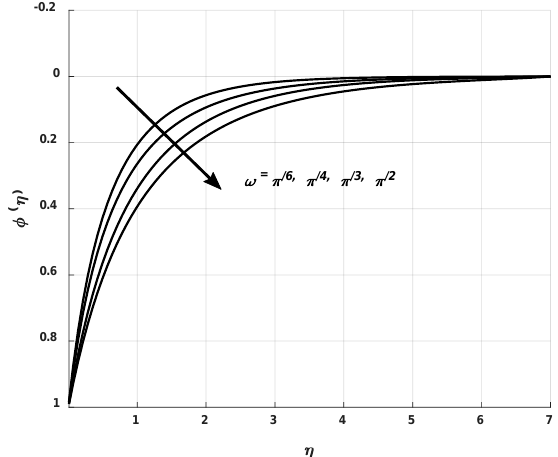
Figure 16. Influence of ε on φ ( η ) .